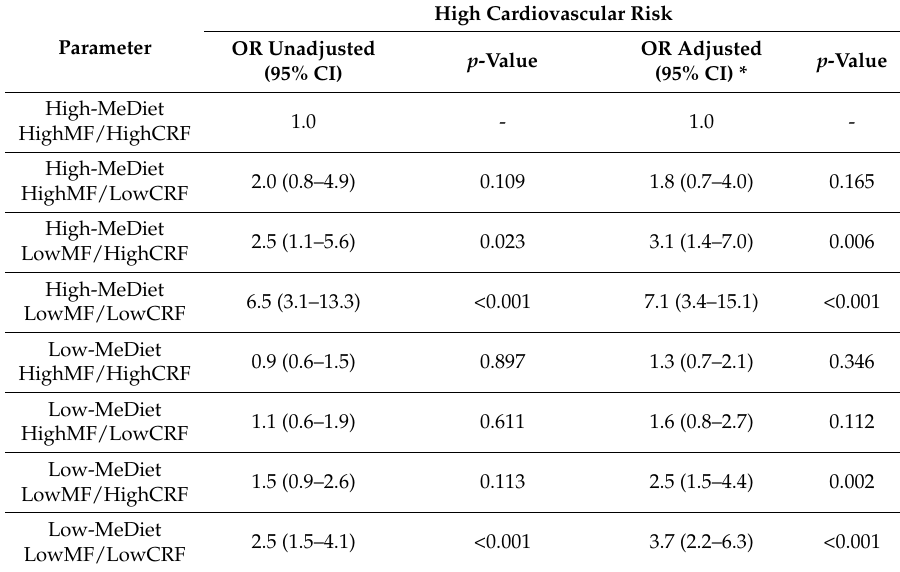
Table 2. Odds ratio of high cardiovascular risk by adherence to a Mediterranean Diet, cardiorespiratory fitness, and muscular fitness